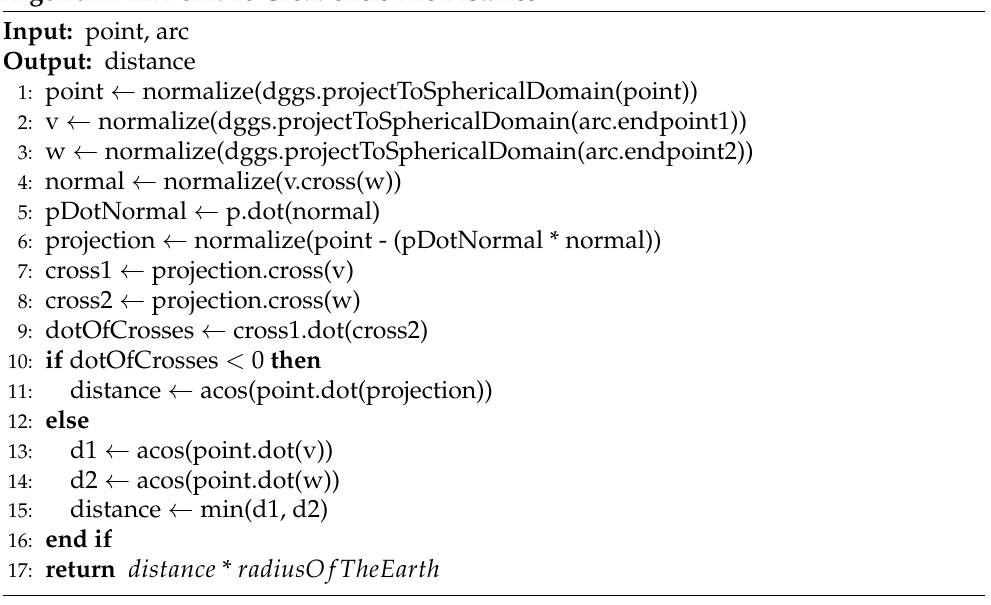
Algorithm A1 Point To Great-circle Arc Distance.